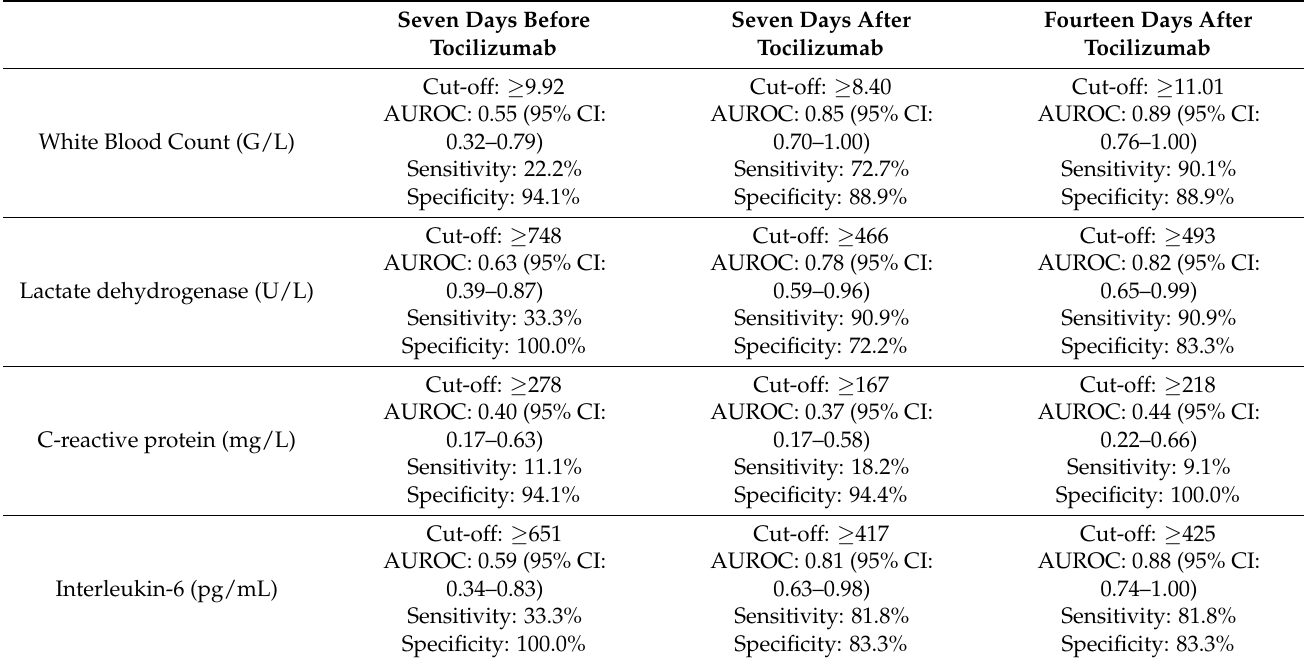
Table 3. Results of ROC analysis. The diagnostic scores were mean inflammatory markers serum concentrations, and the classes of observations were: death (coded as 1) and survival (coded as 0). Seven Days Before Tocilizumab